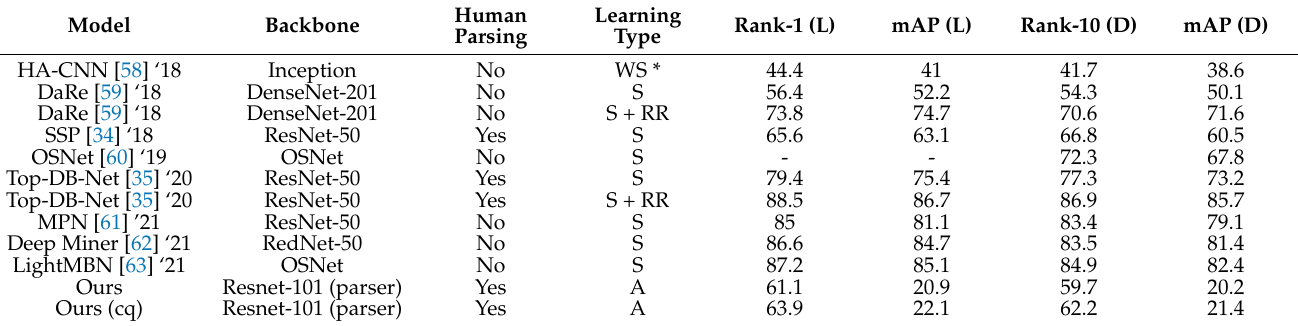
Table 5. Performance comparison on CUHK03